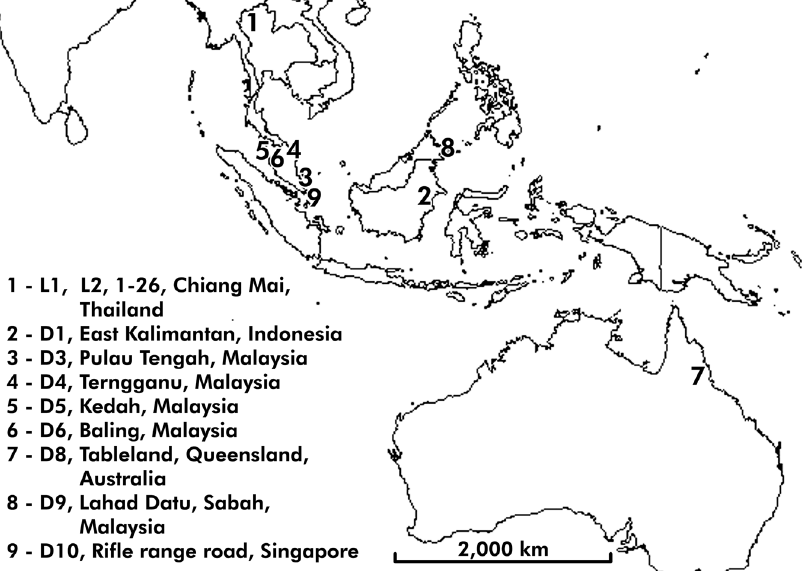
Figure 5. Map of sampling location. Location no. 1 is the location of longan cultivars no. 1–26 and 2 types of lychee (L1 and L2) which have been maintained at Maejo University, Sansai, Chiang Mai, Thailand. Location no. 2–9 represent the location of the herbarium samples. This figure was modified by using the Photoshop program. The source of this figure can be found at https://commons.wikimedia.org/wiki/File:White_World_Map_Blank. png which is licensed under the “Creative Commons Attribution-Share Alike 3.0 Unported” that is free to share (to copy, distribute and transmit the work) and remix (to adapt the